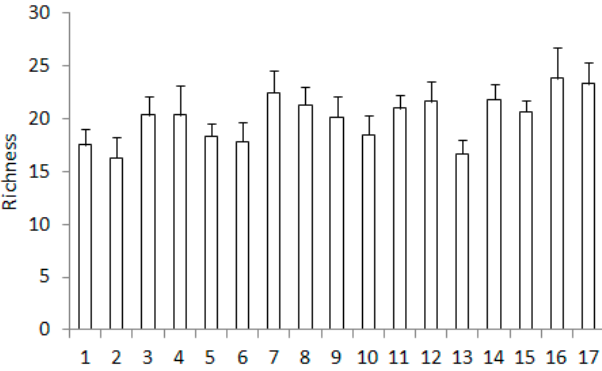
Figure 4. Species richness (mean + SD) of the total zooplankton in the examined sites of the Corgo river.